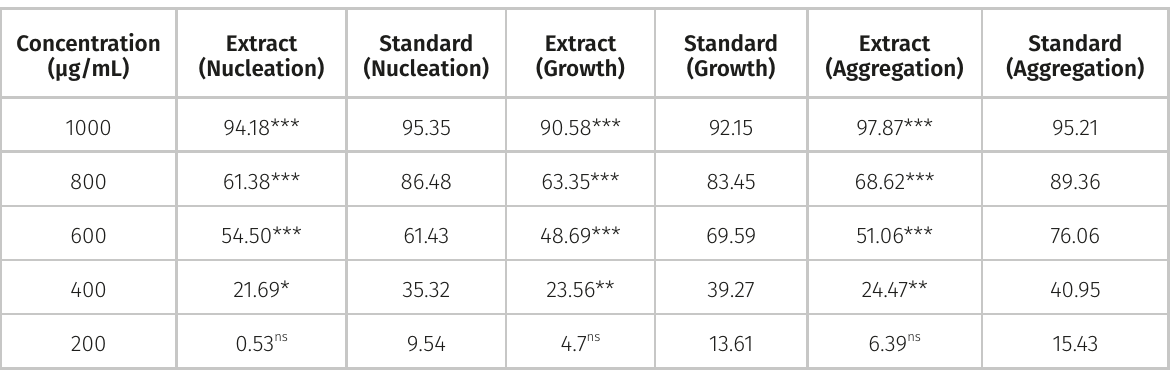
Table VI. Effect of S. hispanica seeds extract and standard on percentage inhibition of crystal nucleation, growth and aggregation assays.